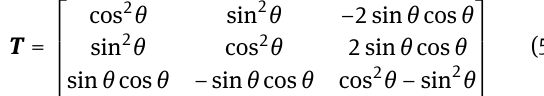
Figure 3: The geometric model of the spherical pipe. (a) The curvilin- ear coordinate system and the Cartesian coordinate system. (b) The structural parameters of the spherical pipe.